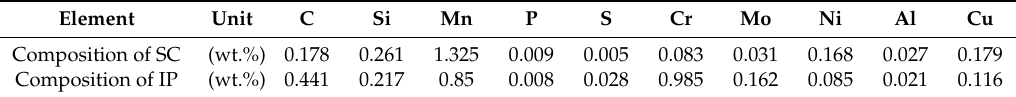
Table 5. Element content (wt.%) of ignition pin (IP) and steel crucible (SC). Element Unit C Si Composition of SC